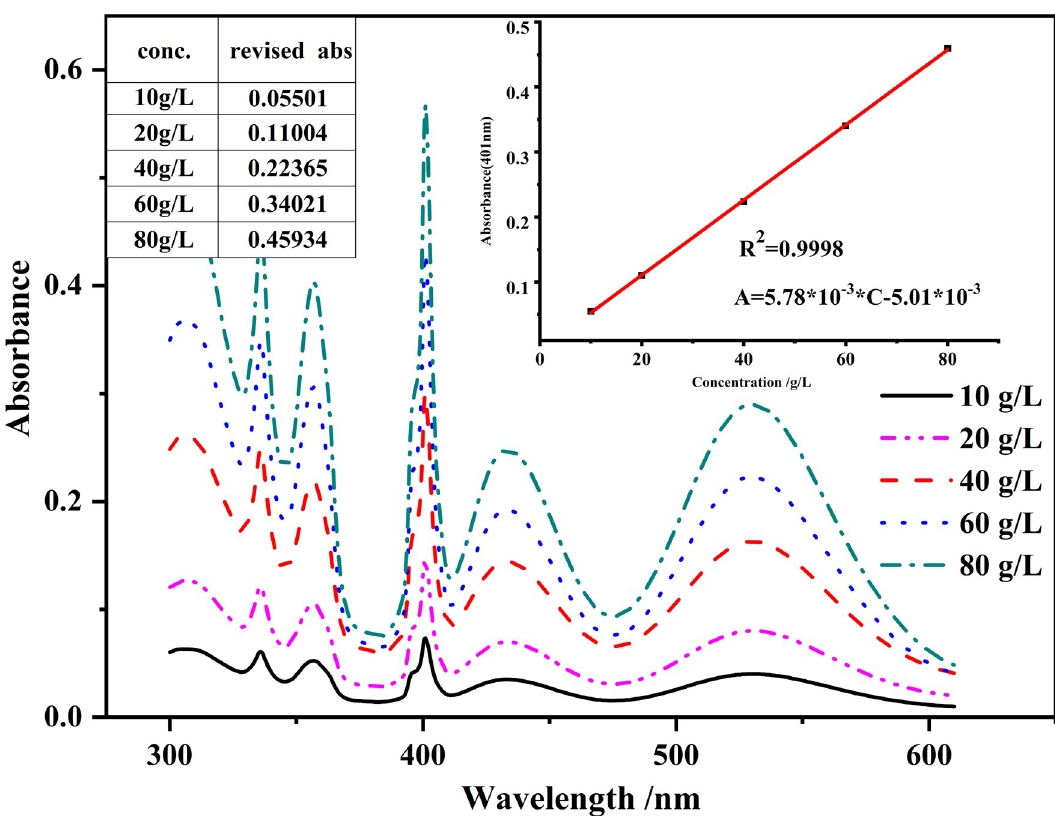
Fig 6. Spectra of MnSO 4 solutions with different concentrations and the revised absorbance at 401nm. Inset is the revised absorbance (by subtracting A sub from linear interpolation) versus the